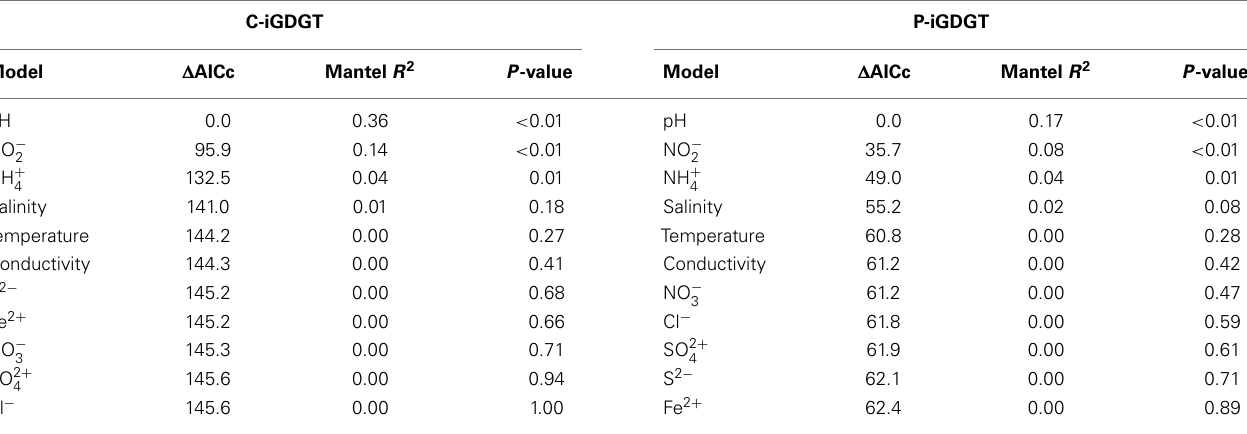
Table 4 | Model ranking using ∆ AICc and Mantel correlation coefficients ( R 2 ) where C-iGDGT or P-iGDGT distance is the response variable.